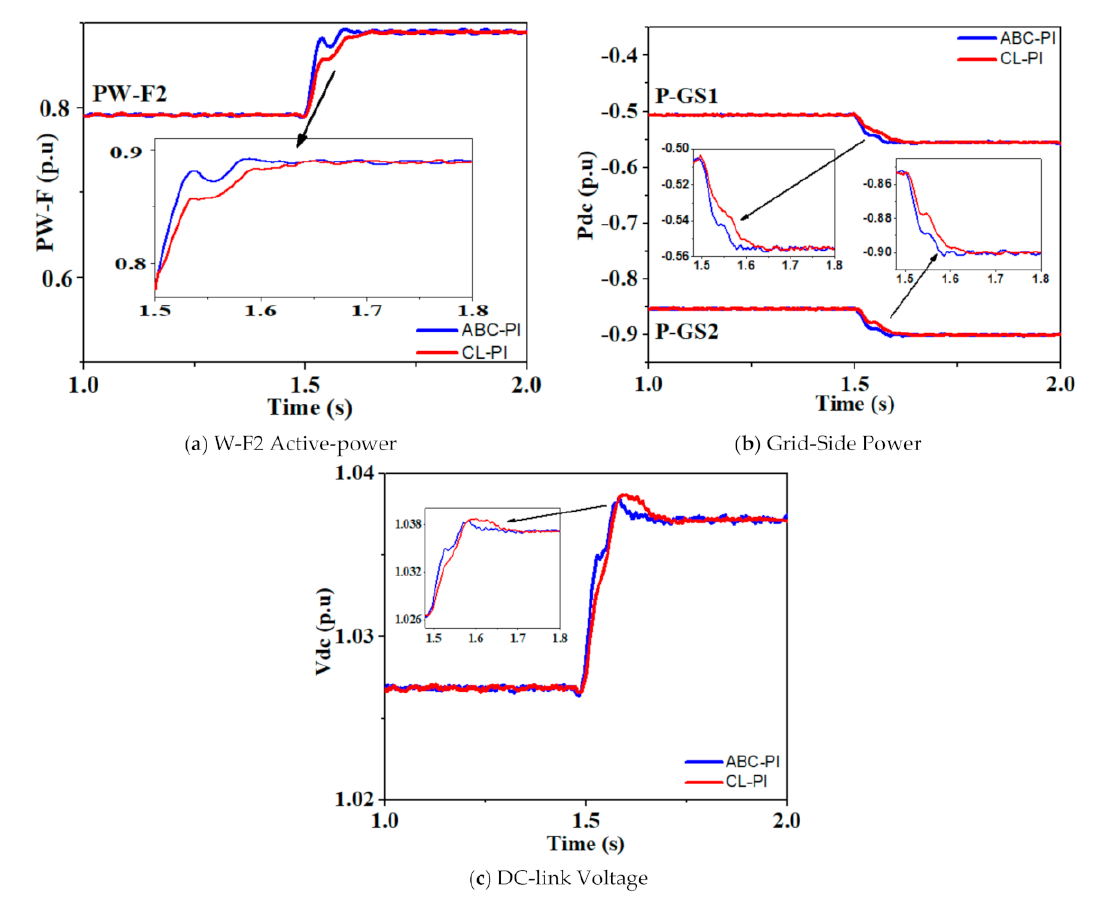
Figure 14. ( a ) W-F2 active-power, ( b ) Grid-side power, ( c ) DC-link voltage during unbalance power generation at W-F2. The referenced-based configuration is assigned to active and reactive power with controlled operating modes. Since the voltage-droop control is employed at the on-shore side grid, at t = 0.50 s, the P-GS1 and P-GS2 change from − 0.40 to − 0.50 p.u and − 0.76 to − 0.86 p.u, respectively, due to a sudden rise in power generation of W-F1. This surplus generated power is divided into the AC grids based on the voltage-droop control characteristics similarly, as W-F2 raises its power output from 0.8 to 0.9 p.u. is shown in Figures 13a–c and 14a–c. Moreover, concerning the voltage drop characteristics in Figure 4, the variation of DC-link voltage during unbalance power generation at W-F2 in Figures 13 and 14 is well within the safe and HVDC network operational limits [13,37]. Further, the slope of voltage droop characteristics for GS-2 is smaller than GS-1, demonstrating that GS-2 absorbs more power than GS-1 generated by the wind